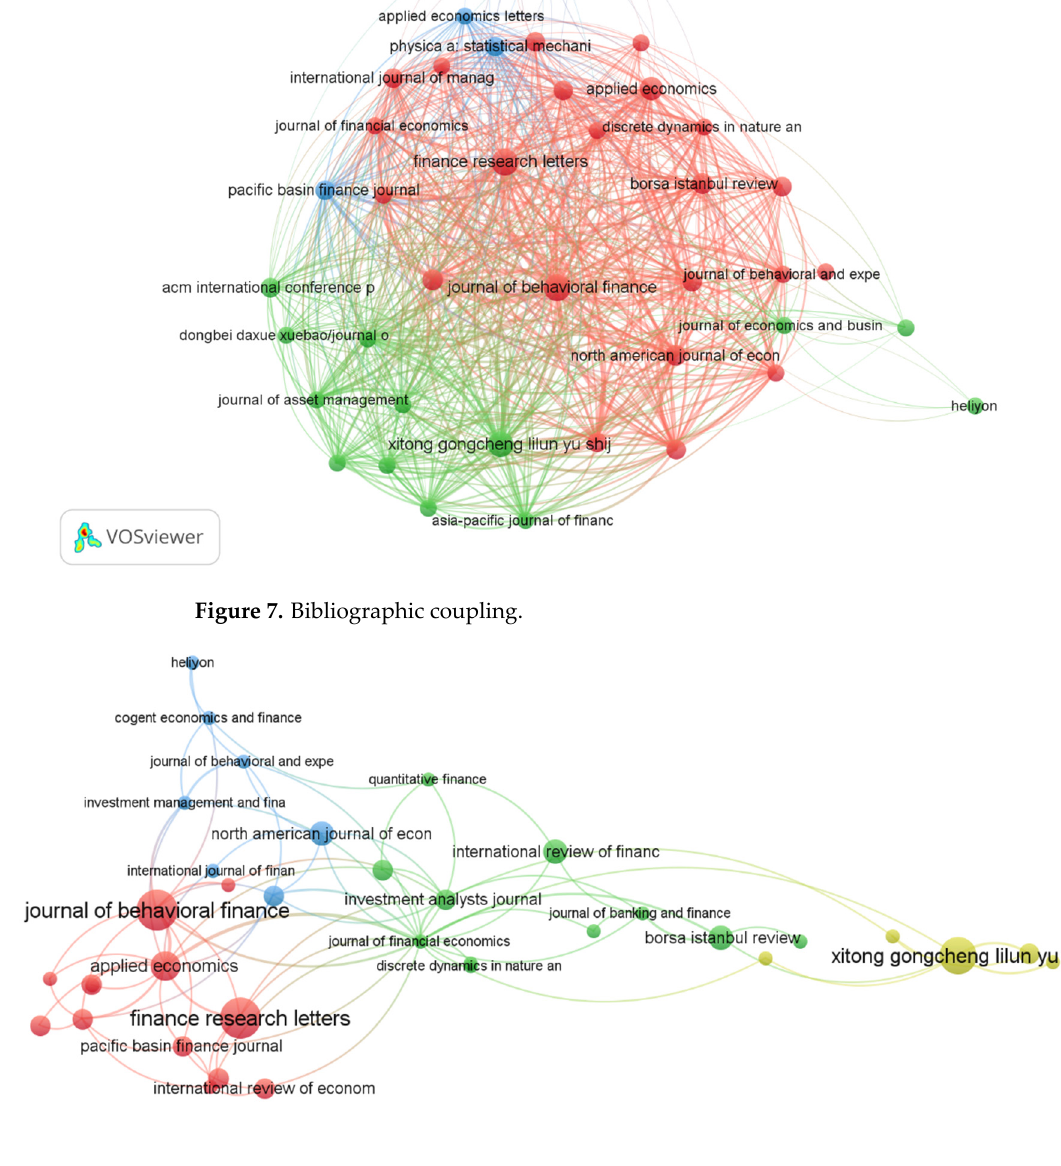
Figure 8. Citations based on sources.